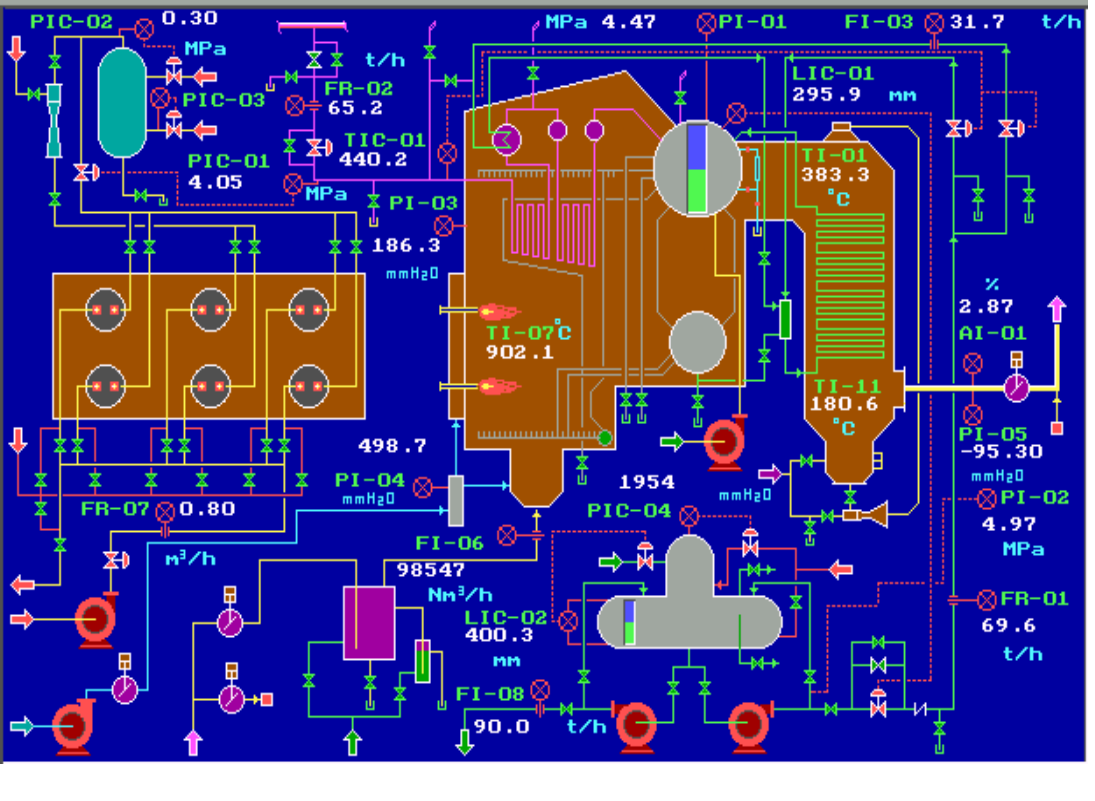
Figure 4. Boiler system flow sheet.